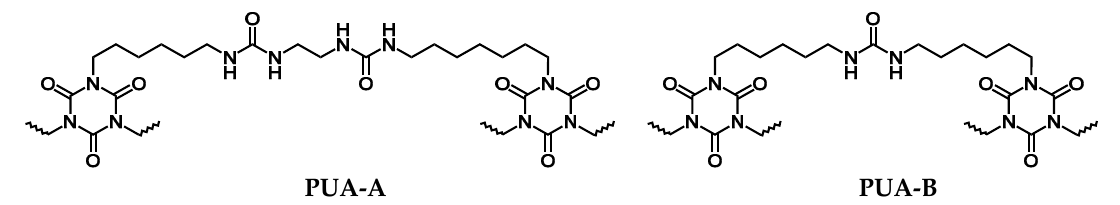
Scheme 1. Structure of PUA obtained from the reaction of Desmodur N3300 and ethylenediamine in propylene carbonate (PUA-A) and from the reaction of Desmodur N3300 and water (PUA-B).